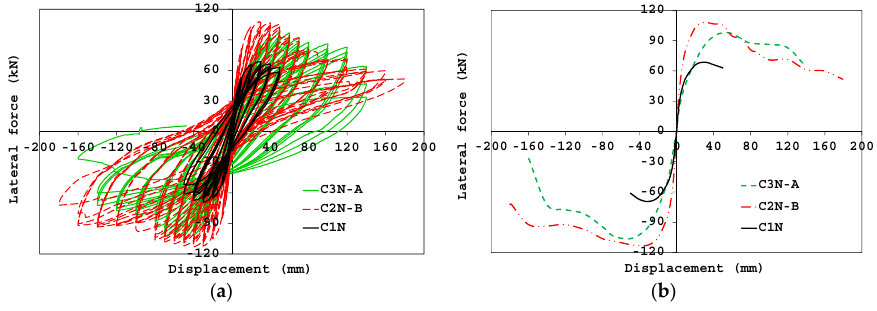
Figure 7. F – Δ hysteresis curves ( a ) and envelopes ( b ): columns C1N, C2N-B and C3N-A.